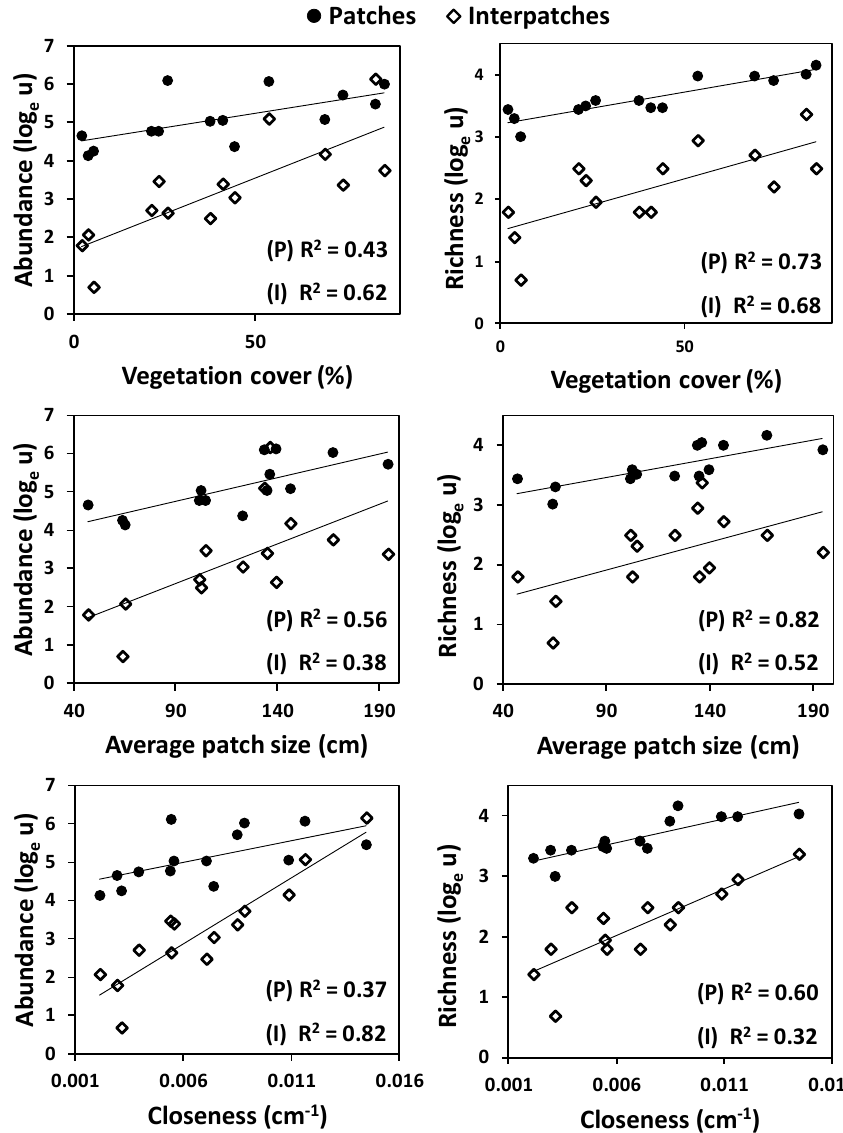
Figure 1. Relationships between log-scaled ground arthropod abundance (left panels) and richness (right panels) and landscape vegetation pattern metrics (vegetation cover, average patch size, and patch closeness) as a function of the type of microhabitat: Patches (P) and Inter-patches (I). Continuous lines represent statistically significant linear regressions ( p ≤ 0.05) between the respective log-transformed response variable and the explanatory variable for each microhabitat type.